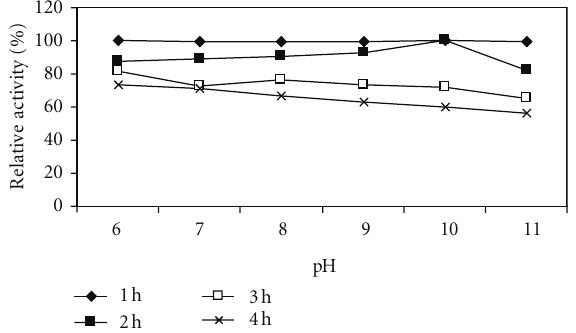
Figure 10: E ff ect of pH on stability of xylanase from Bacillus arseni- ciselenatis DSM